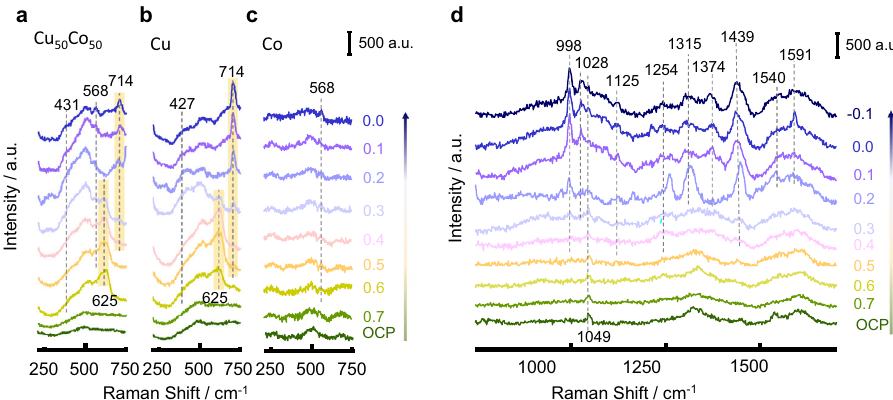
Fig.5|ElectrochemicalSHINERSspectraofNO 3 − RR. SHINERSspectrabetween230 – 750cm − 1 onCu 50 Co 50 ( a ),Cu( b ),andCo( c ).SHINERSspectrabetween750 – 1700cm − 1 on Cu 50 Co 50 ( d ) in 100mM KNO 3 +10mM KOH during cathodic polarization from 0.7 to −